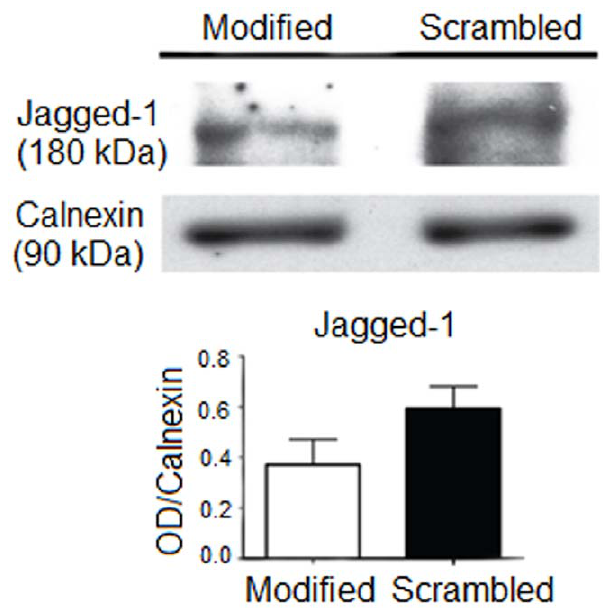
Figure 9. Western blot of whole cell lysates from Hep G2 cells treated with the PS-modified SL 2 aptamer and scrambled sequence (control). The expression of Jagged-1 protein in Hep G2 cells was assessed. Calnexin protein was used as a loading control. Error bar=SEM.